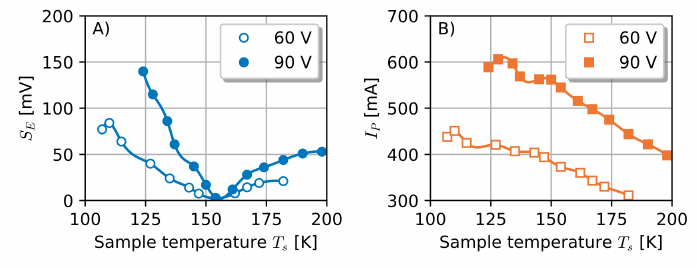
Figure 2. ( A ) The temperature dependencies of pulsed emission signal S E . ( B ) Pulsed current I P in the sample at 60 V (full symbols) and 90 V (open symbols) pump